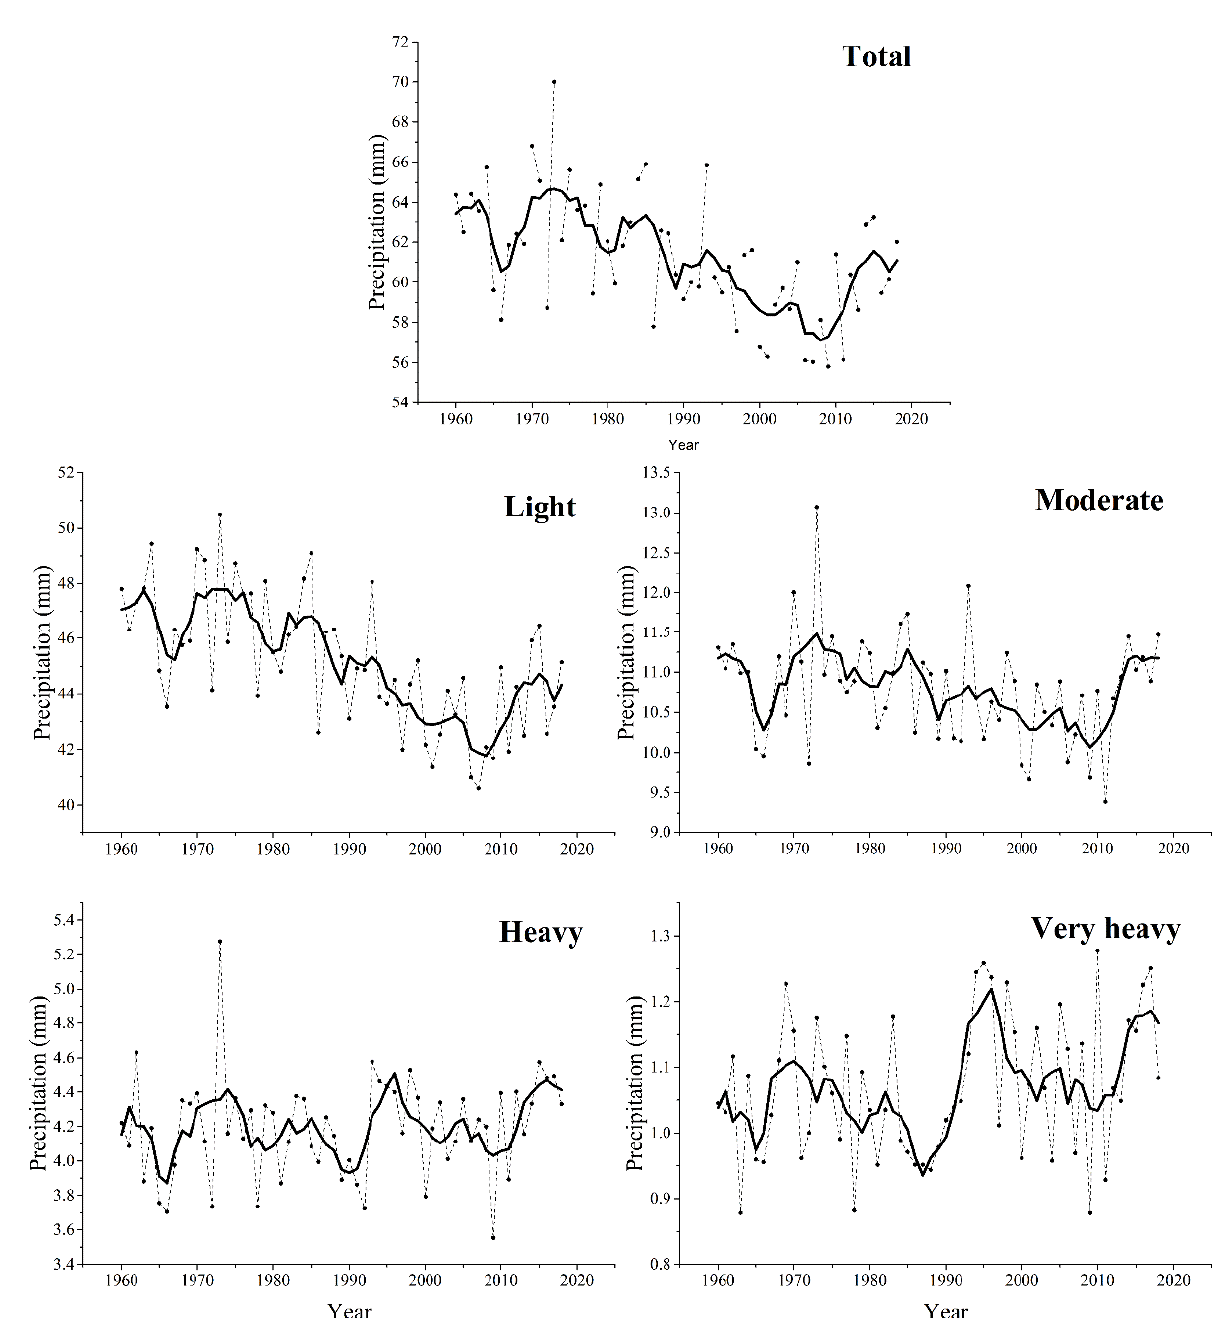
Figure 7. National annual series for number of precipitation days during the rainy season in China: total rain-season precipitation, light precipitation, moderate precipitation, heavy precipitation, and very heavy precipitation. The solid line is the result of smoothing with a 9-year binomial filter with reflect ends. The dotted line is national series for precipitation grade.